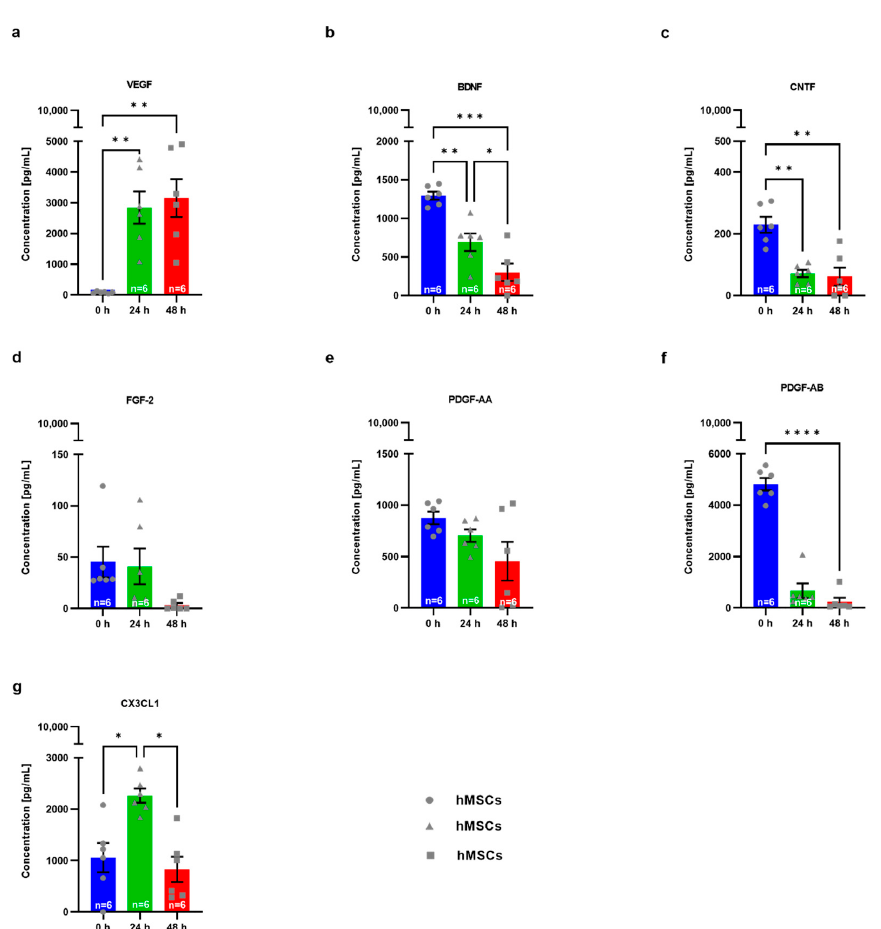
Figure 4. Secretome analysis of protein levels of growth factors in hMSC medium. 100,000 hMSCs were seeded and after 5 min (indicated as timepoint 0), 24 h and 48 h cell supernatant was collected. Supernatants were co-incubated with respective beads, and incubated in assay buffer. After washing mixed biotinylated secondary antibodies were added and incubated, followed by washing. Quantification was performed by adding SA-PE. Individual standard curves and concentrations for each analyte were calculated. Pure hMSC medium was used as a negative control and, thus, subtracted from all measured values. hMSC medium enriched with 1% Penicillin/Streptomycin, heparine 2 IU/mL and 8% human plate lysate was used for baseline measurement and thus subtracted from all measured values. ( a ) VEGF protein levels ( n = 6). ( b ) BDNF protein levels ( n = 6). ( c ) CNTF protein levels ( n = 6). ( d ) FGF-2 protein levels ( n = 7). ( e ) PDGF-AA protein levels ( n = 6). ( f ) PDGF-AB protein levels ( n = 6). ( g ) CX3CL1 protein levels ( n = 6). Statistical analyses were performed with repeated measurements one-way ANOVA and Tukey’s multiple comparisons post-hoc test: * p < 0.05, ** p < 0.01, *** p < 0.001 and **** p < 0.0001. Single values are represented as repeated measurements together with mean ±